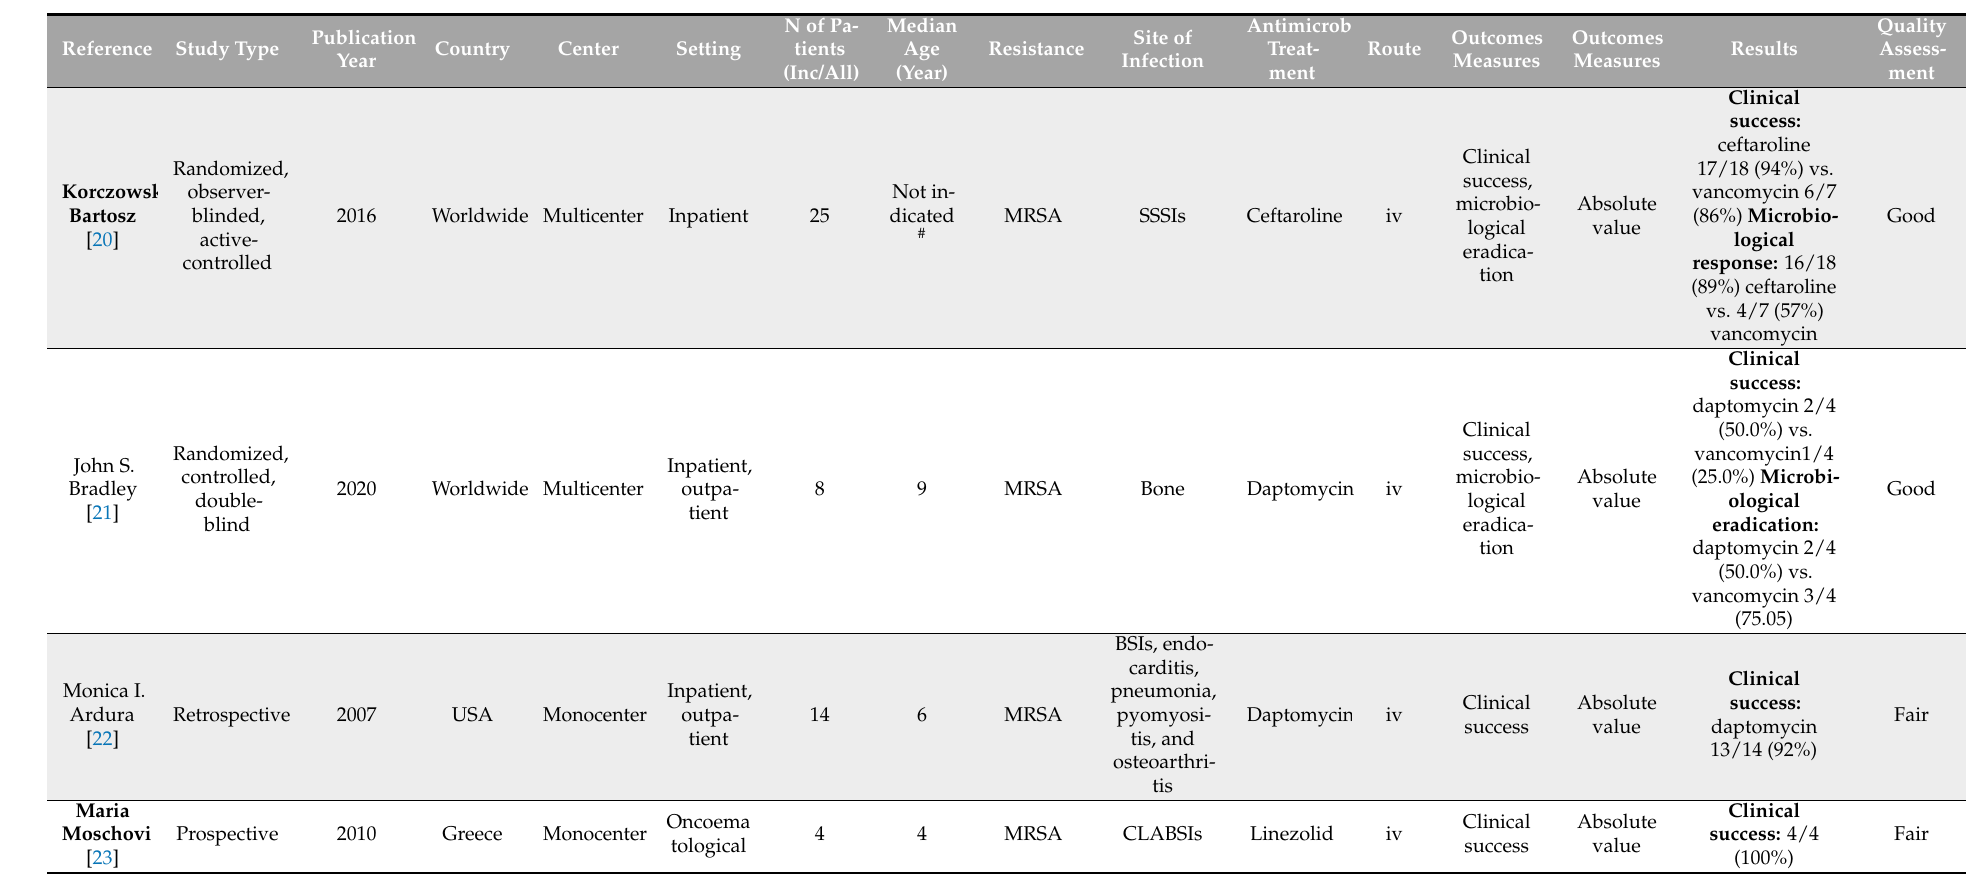
Table 1. Treatment choices and outcomes for methicillin-resistant Staphylococcus aureus